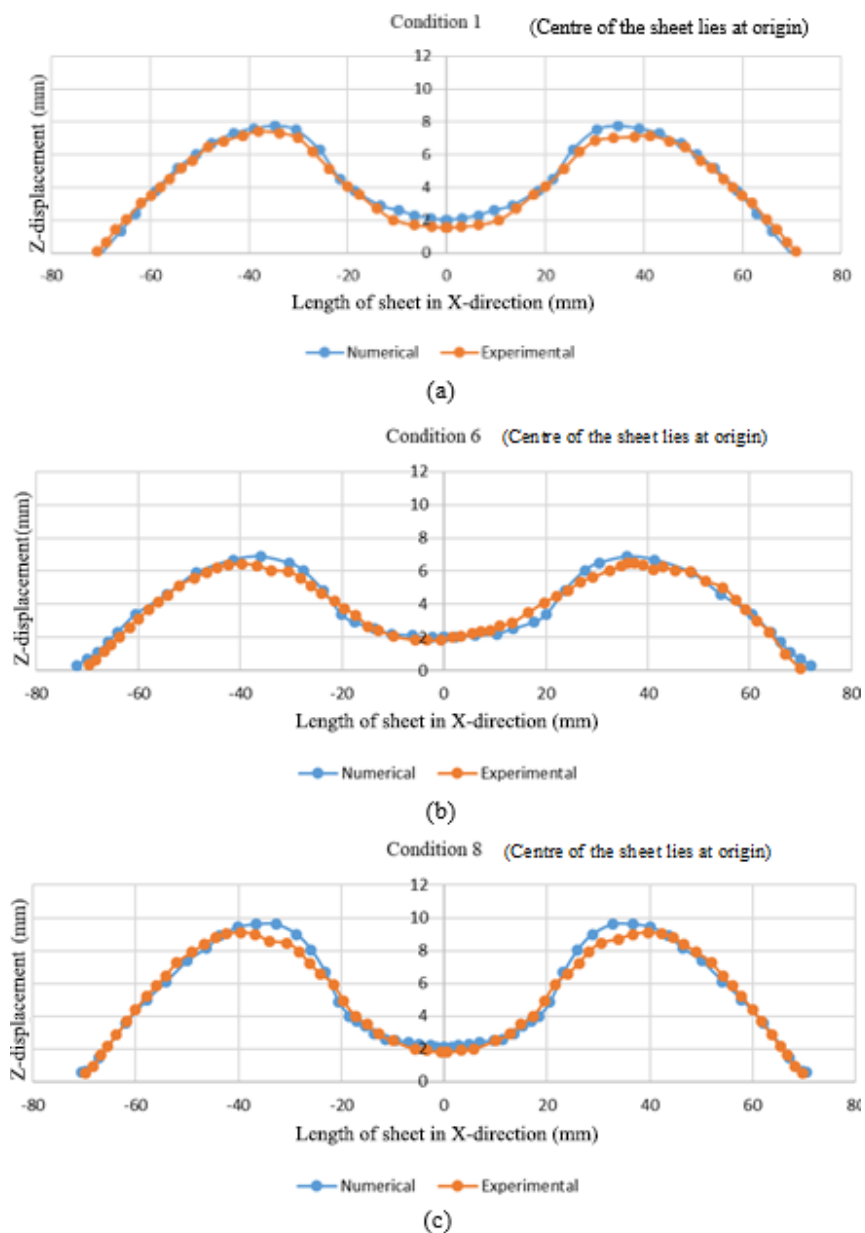
Figure 15. Numerical and experimental sheet height along the X direction. (a) Voltage = 2400V, thickness = 1.02mm, N = 6. (b) Volt- age = 2600V, thickness = 1.63mm, N = 6. (c) Voltage = 2800V, thickness = 1.22mm, N =